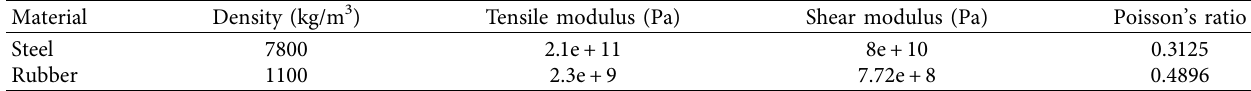
Table 2: Materials parameter of SEA model.